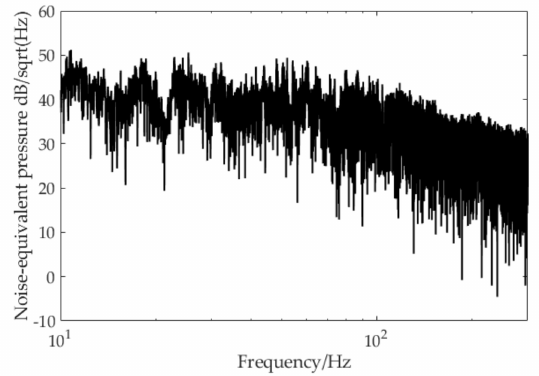
Figure 10. Noise-equivalent pressure level of cuboid-type